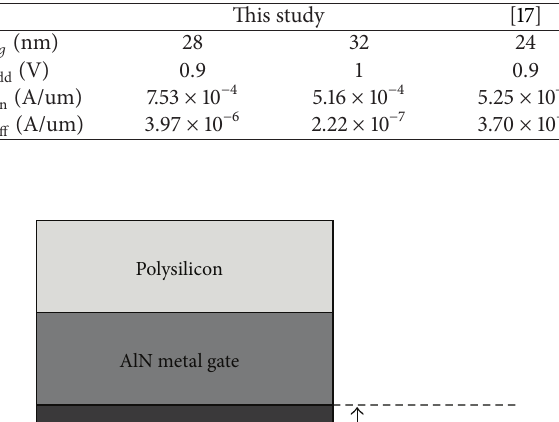
Table 1: Performance summary of simulated devices.